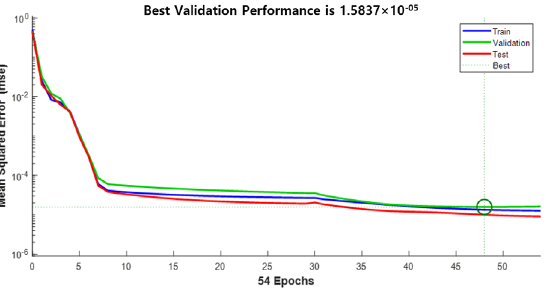
Figure 9. MSE of second step ANN.